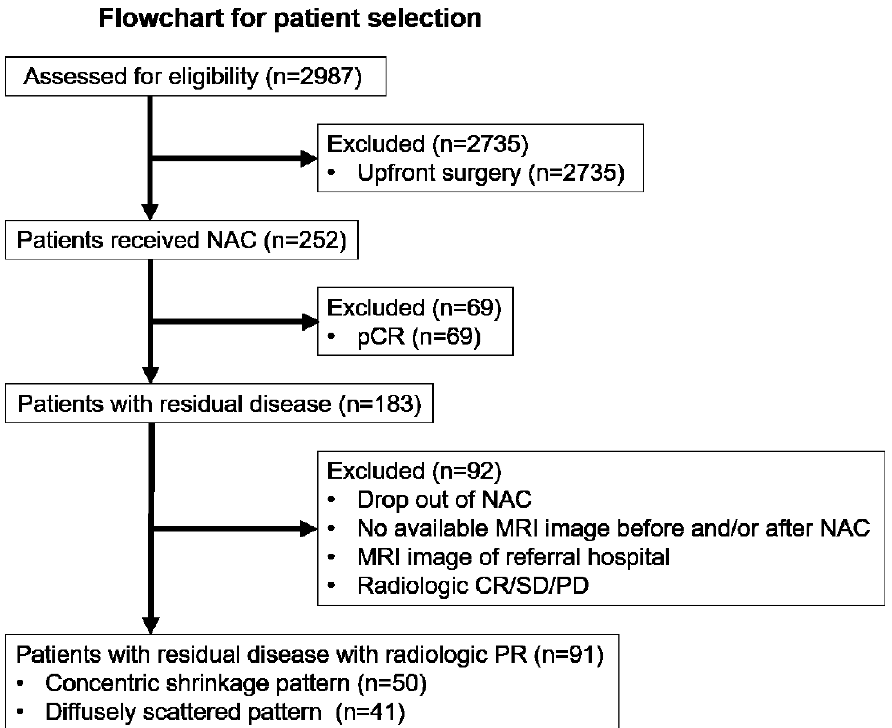
Figure 1. Flowchart for patient selection. NAC, neoadjuvant chemotherapy; PR, partial response; CR, complete response; SD, stable disease; PD, progressive disease.